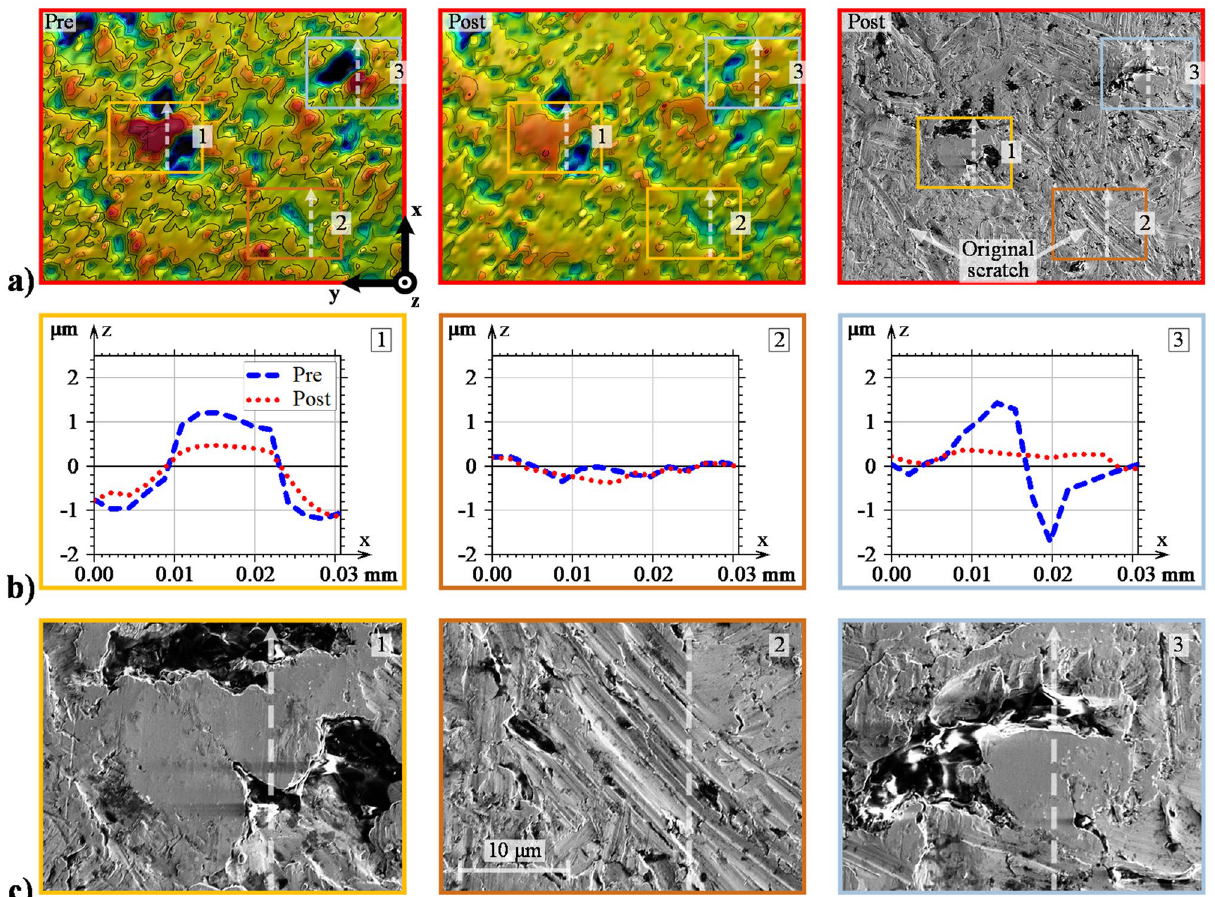
Figure 3. Detailed evaluation of the Ref-derived asperities: ( a ) enlarged view of area I in Fig. 2, ( b ) 2D profiles of prominent asperities taken in the vertical direction (direction of sliding), and ( c ) SEM analysis of the corresponding